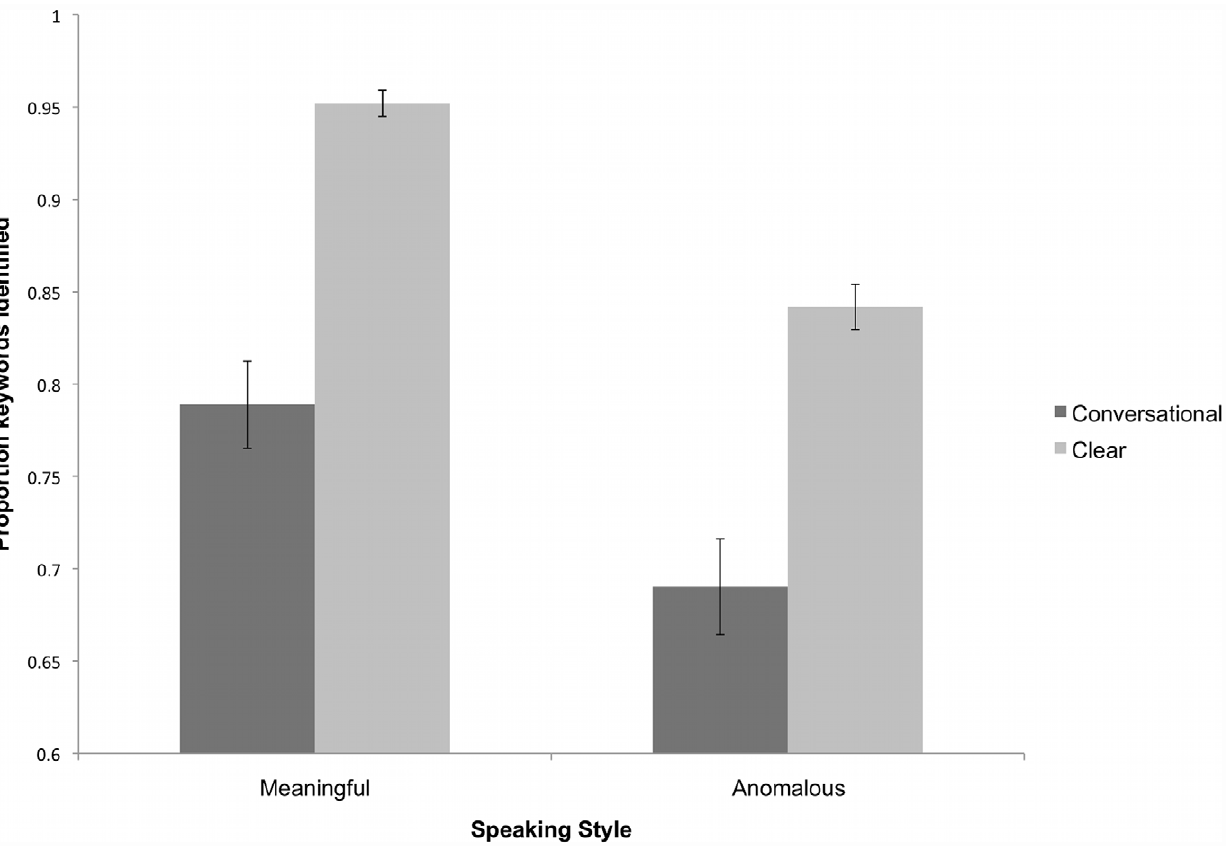
Figure 2. Average proportion of keywords identified from semantically anomalous and meaningful sentences produced in clear and conversational speaking styles. Error bars represent standard error. doi:10.1371/journal.pone.0043753.g002 PLOS ONE |